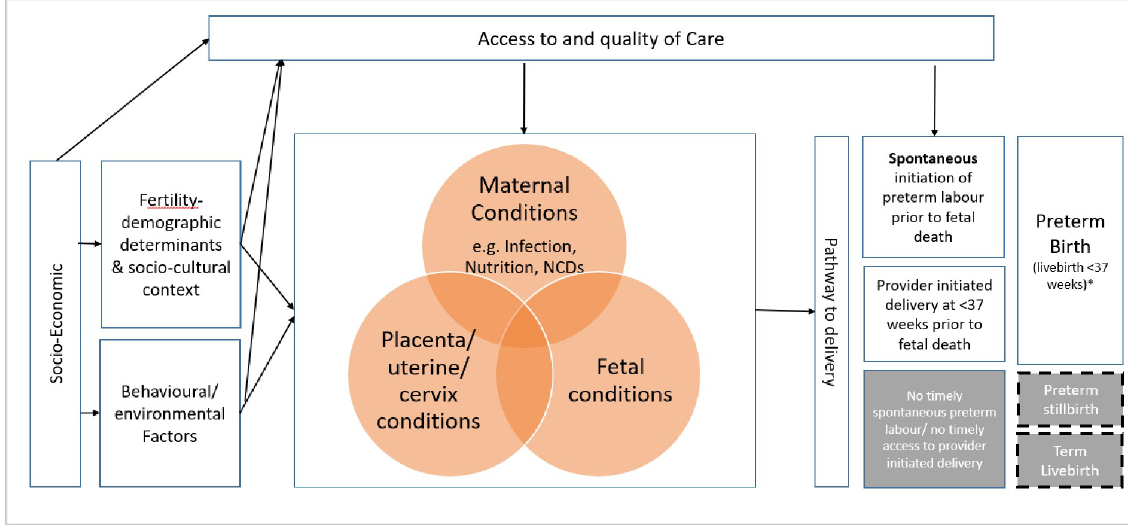
Fig 2. Conceptual framework for covariate selection. Note: Adapted from previous conceptual frameworks